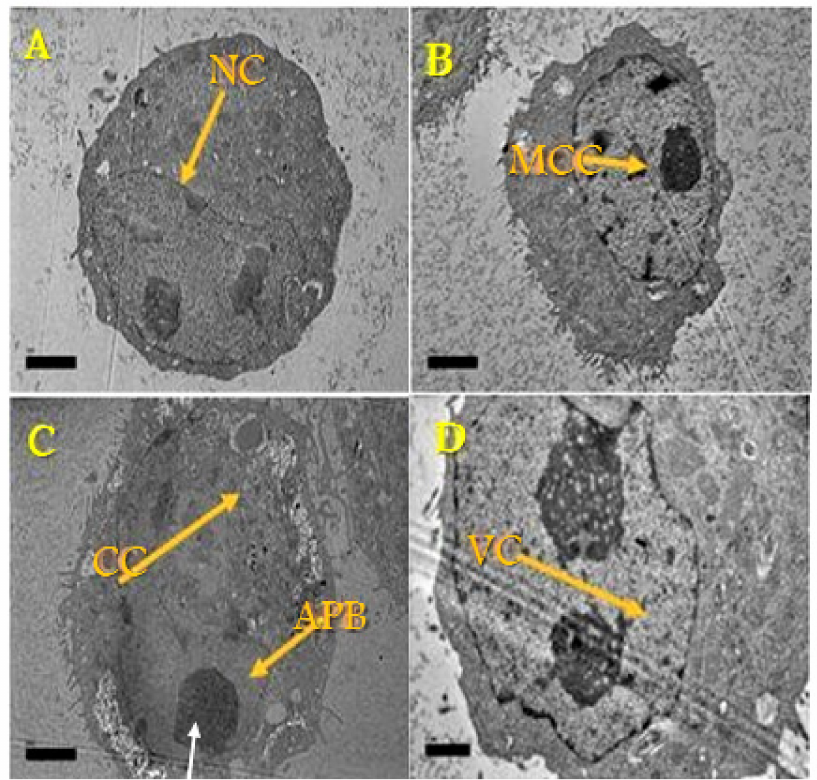
Figure 3. Transmission electron microscope of ultrastructural features of untreated MCF-7 cancer cells. ( A ) Control (untreated) cells with nucleus represented by NC (magnification × 9000). ( B ) Cells treated with Ar-CC-NPs with condensed cristae of mitochondria represented by MCC (magnification × 8000). ( C ) Cells treated with DOX alone will cell dispersion represented by CC and apoptotic body (APB) (magnification × 9000). ( D ) Cells treated with DOX-Ar-CC-NPs with vesicles in the cytoplasm VC (magnification ×